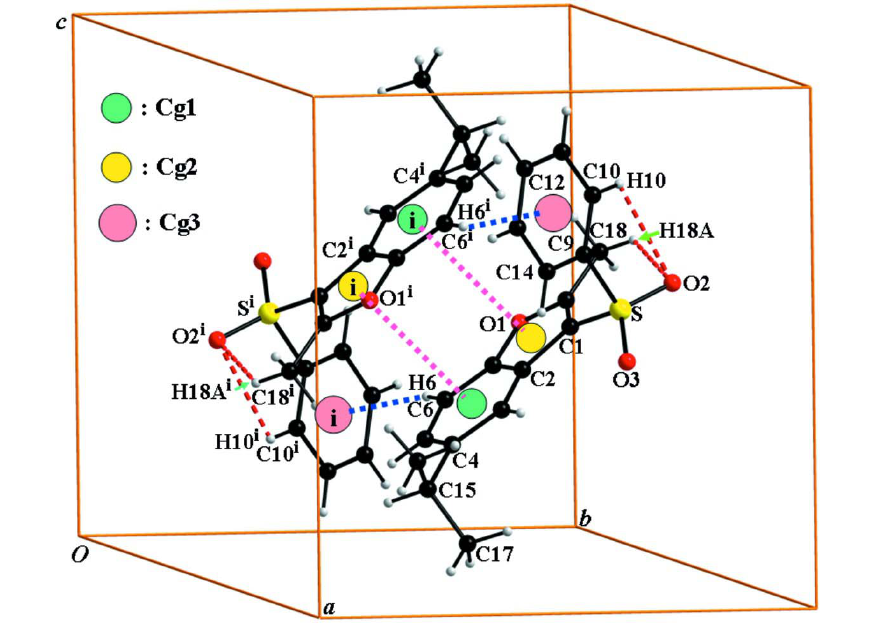
Figure 2 π — π , C—H··· π and C—H···O interactions (dotted lines) in the title compound. Cg denotes the ring centroids. [Symmetry code: (i) - x + 1, - y + 1, - z +